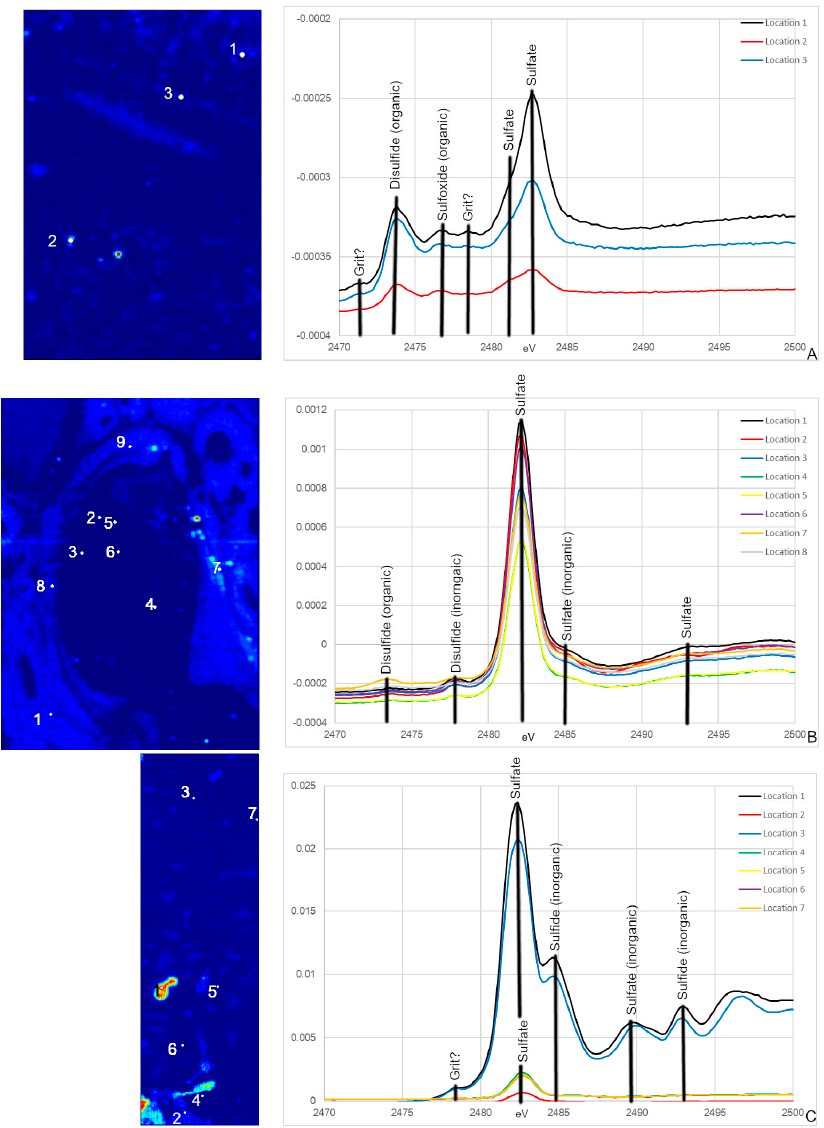
Figure 6. S XANES from NCSM 17977 ( C. moluccensis radius; ( A )), MOR 1125 ( T. rex femur; ( B )), OMN 34784 ( T. tilletti tibia; ( C )) with peaks labeled using peak designations based on [57,58]. The locations for the XANES spectra are labeled on the corresponding S PCA2 maps. Both NCSM 17977 and MOR 1125 exhibit organic disulfide and sulfate peaks. MOR 1125 and OMNH 34784 also have inorganic S peaks for disulfides, sulfates and for OMNH 34784,